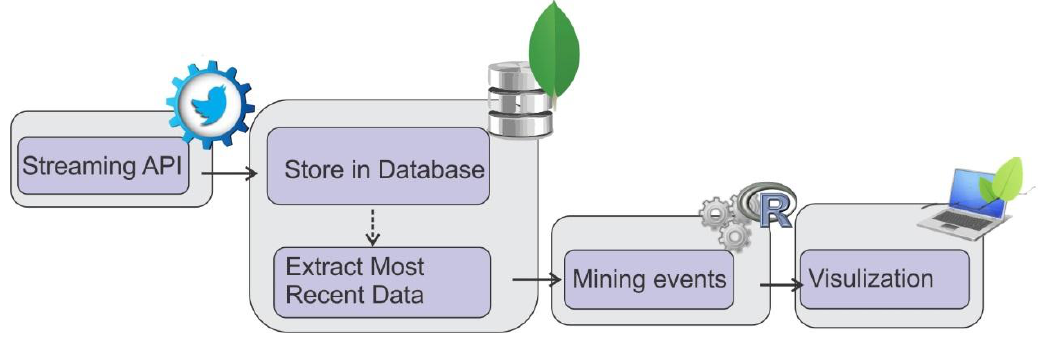
Figure 1. The overall data process flow.